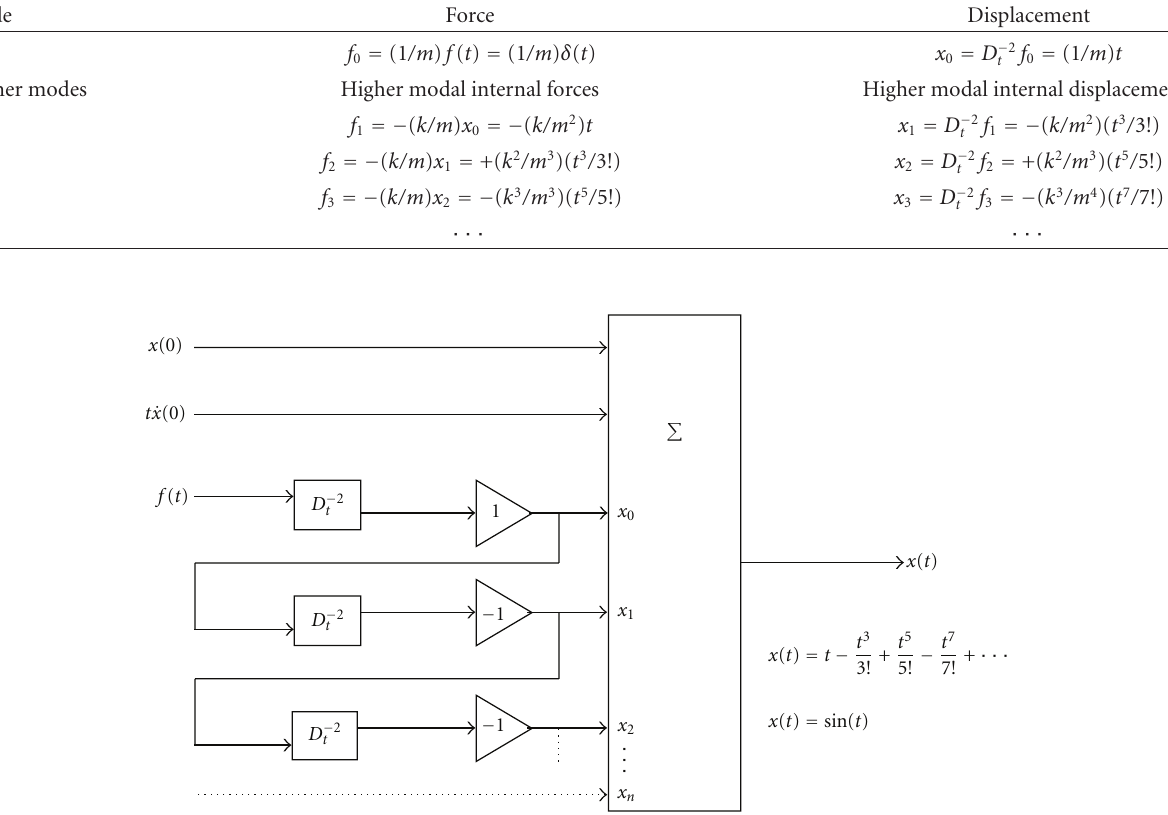
Figure 1: Block diagram showing decomposition and solution of second-order di ff erential